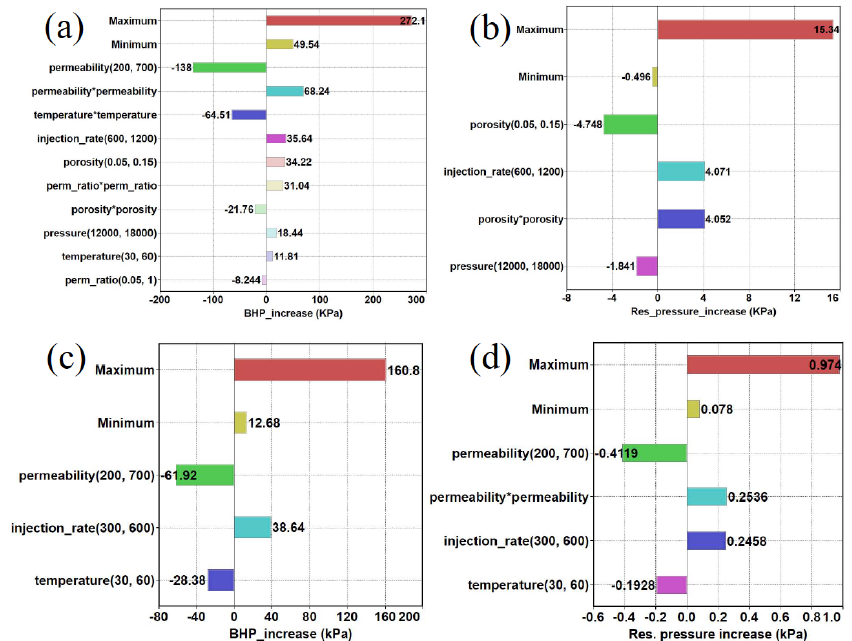
Figure 9. Tornado sensitivity charts for the effect of important parameters on pressure buildup: ( a ) bottomhole pressure buildup for supercritical CO 2 injection, ( b ) average reservoir pressure buildup for supercritical CO 2 injection, ( c ) bottomhole pressure buildup for low-salinity water injection, and ( d ) average reservoir pressure buildup for low-salinity water injection (see Table 1 for the ranges).